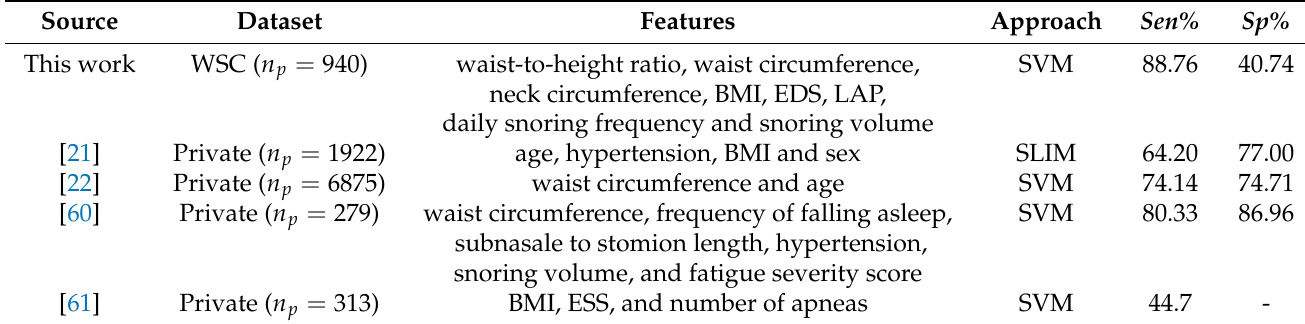
Table 5. A comparison of recent works developed for EHR-based screening of OSA through machine